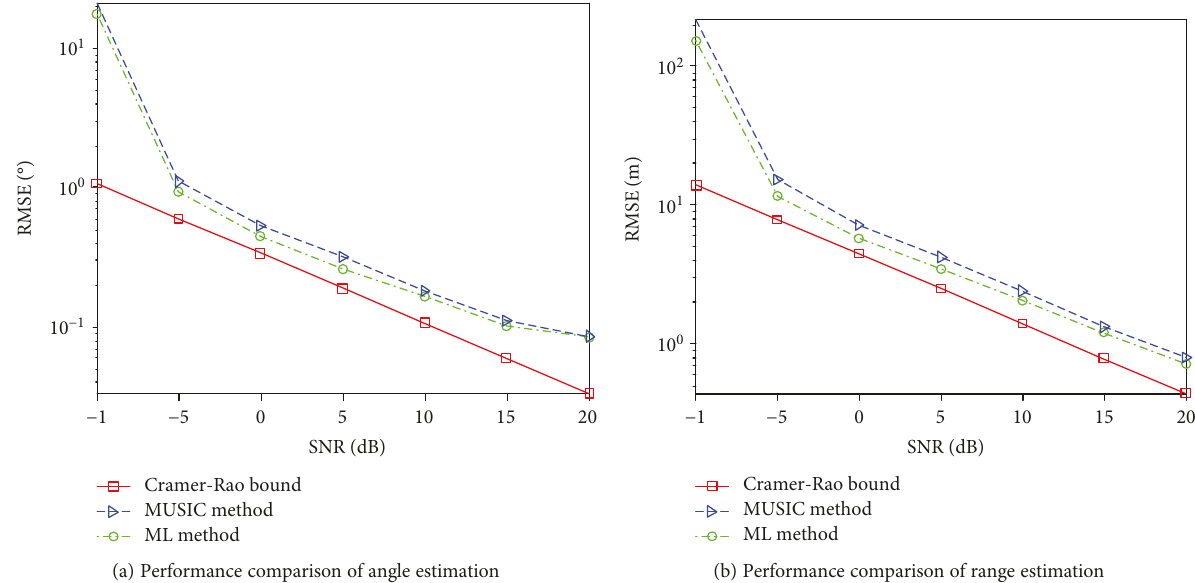
Figure 5: Performance comparison of range and angle joint